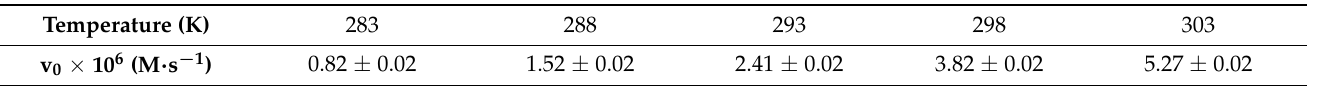
Table 3. Influence of temperature over the initial rate. [HOONO] = 8.00 × 10 − 5 M, [BZH] = 4.00 × 10 − 5 M, I = 0.1 M, pH =